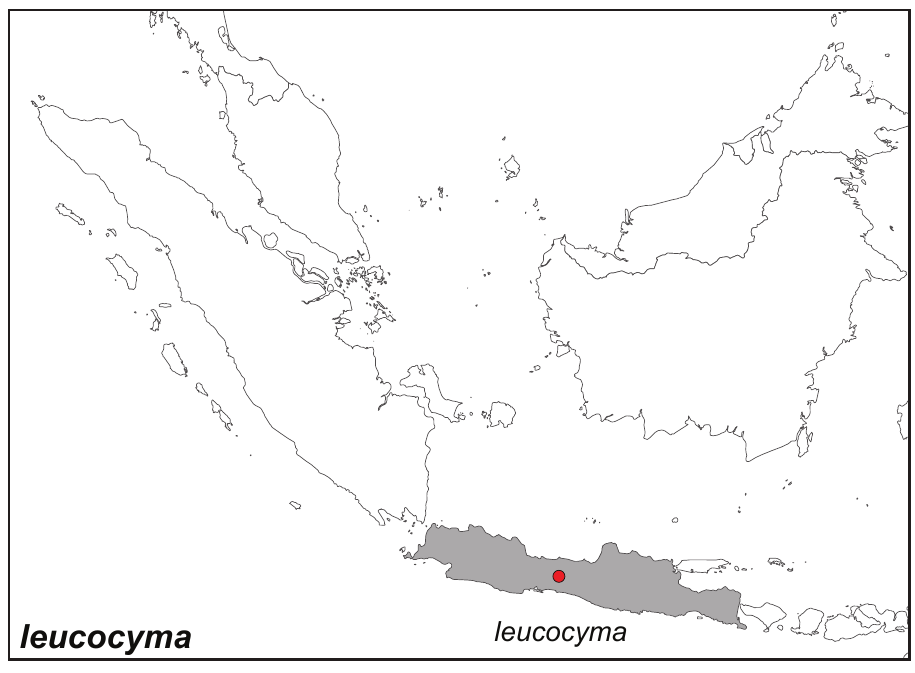
Figure 43. Distribution map of Elymnias leucocyma .